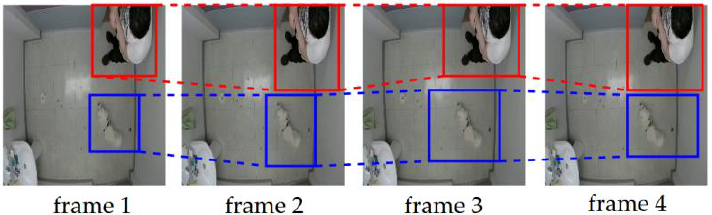
Figure 2. Examples of tubelets. The tubelet in red represents the human’s bounding boxes and the tubelet in blue represents the dog’s bounding boxes.